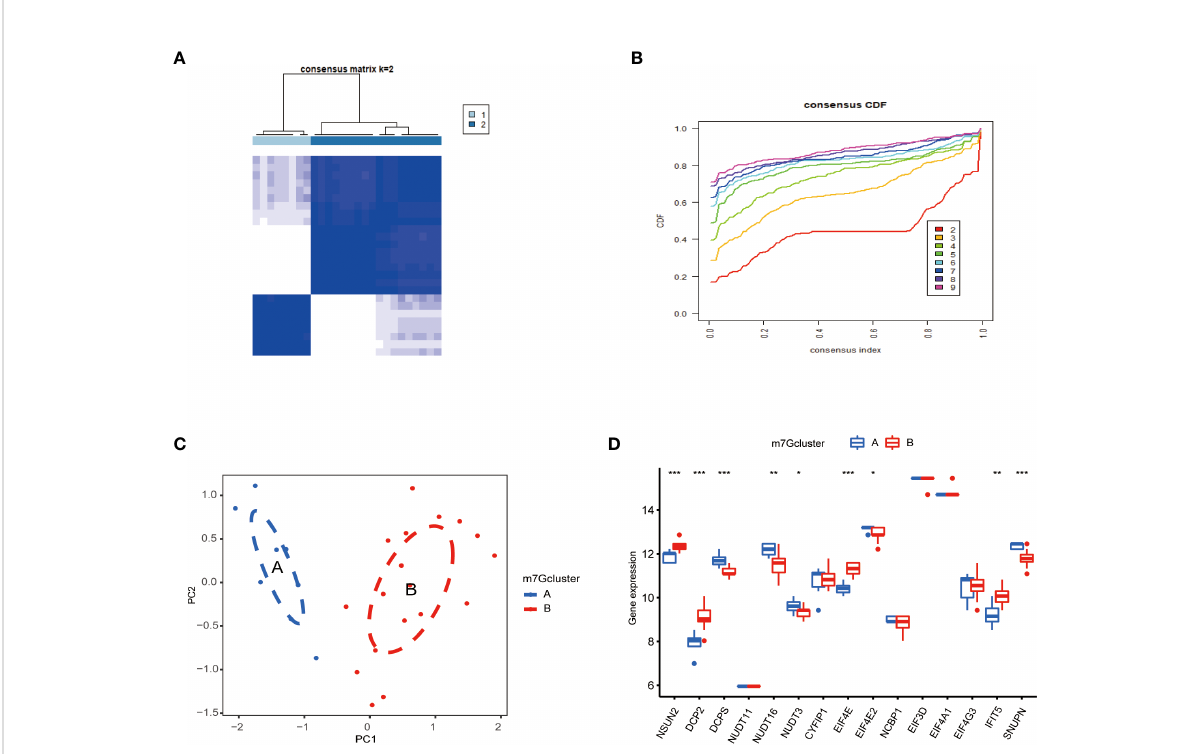
FIGURE 4 Consistent clustering of m 7 G genes. (A) Consistency of clustering results heatmap (k = 2). (B) Consensus cluster cumulative distribution function curve(k=2). (C) PCA analysis. Different colors represent different groups. As shown in the diagram, groups A and B are separated without any intersection. (D) Expression of 15 kinds of m 7 G regulators in Cluster. The abscissa represents m 7 G differential gene, and the ordinate represents the expression distribution of this related gene. *P < 0.05, **P < 0.01, and ***P <